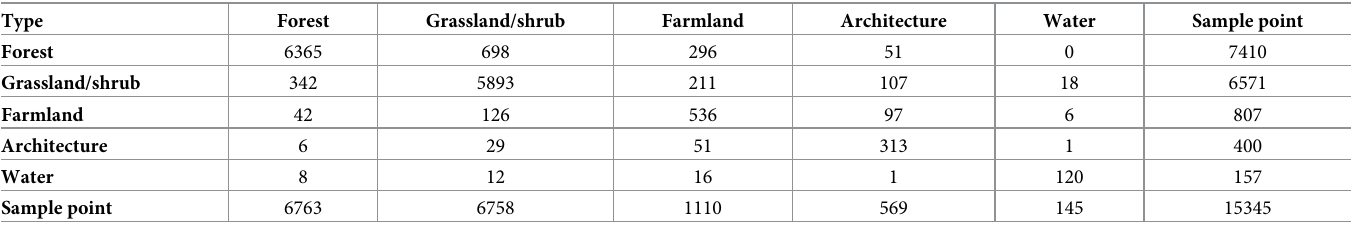
Table 3. Confusion matrix for the object-oriented classification of Baili